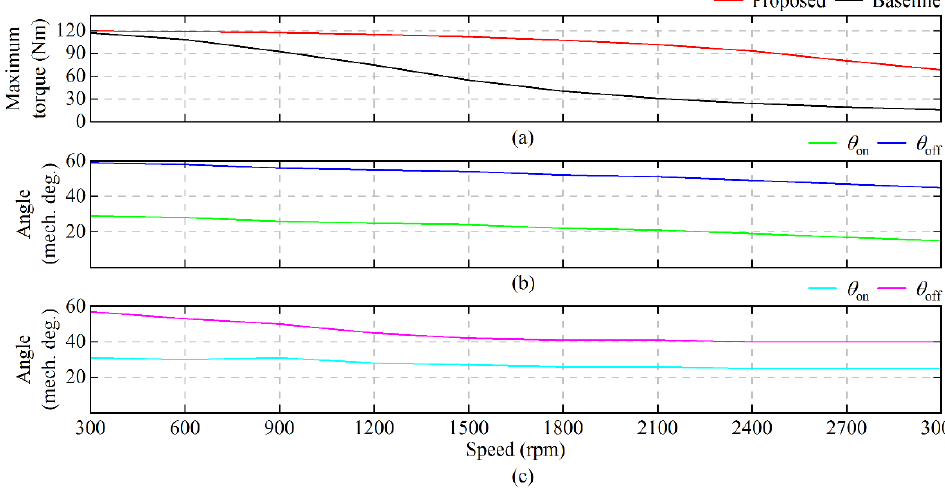
Figure 16. Maximum torque-speed characteristics of the four-phase SRM drive ( a ). Optimal turn-on and turn-off angles with the proposed scheme ( b ), and the baseline scheme ( c ).